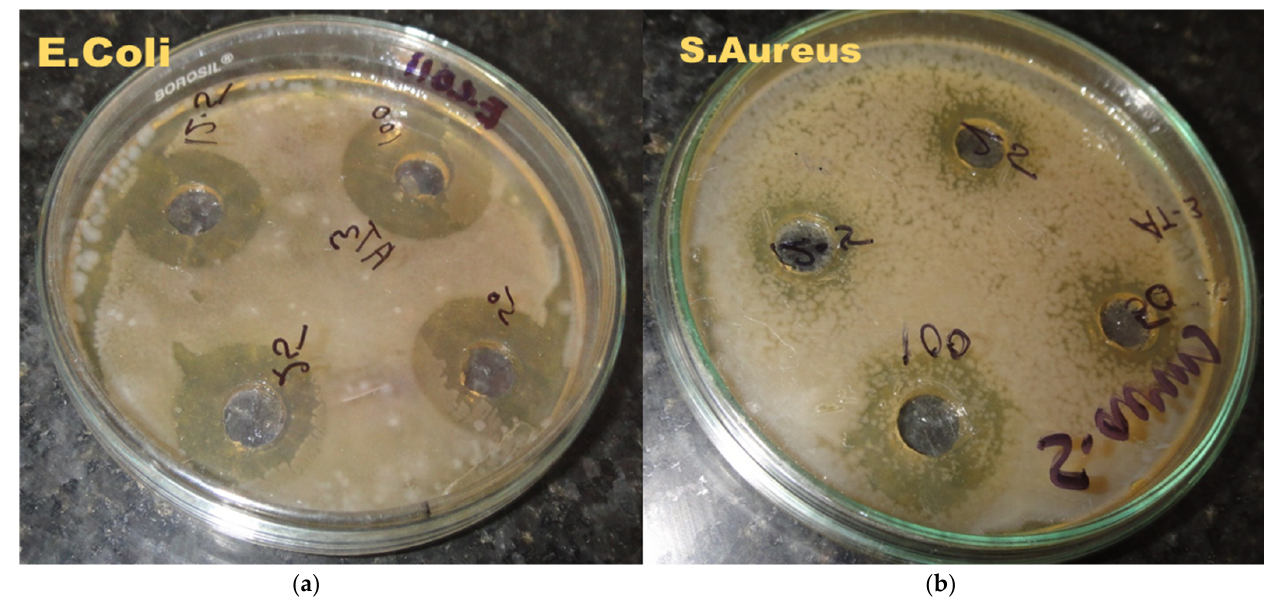
Figure 5. Antimicrobial activity of curcumin nanoemulsion for ( a ) E. coli and ( b ) S. aureus .